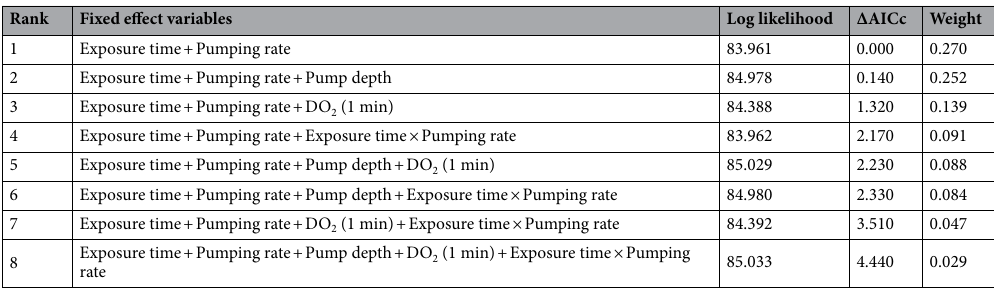
Table 6. Ranking of candidate generalized linear mixed models (beta error structures with logit link) to explain the vitality of Atlantic mackerel ( Scomber scombrus ) during pumping related crowding during purse seine capture. The “DO 2 (1 min)” term indicates a moving average of dissolved oxygen conditions in the net 1 min prior to vitality sampling. AICc refers to Akaike Information Criteria (corrected for small sample size) and “Weight” to normalised Akaike